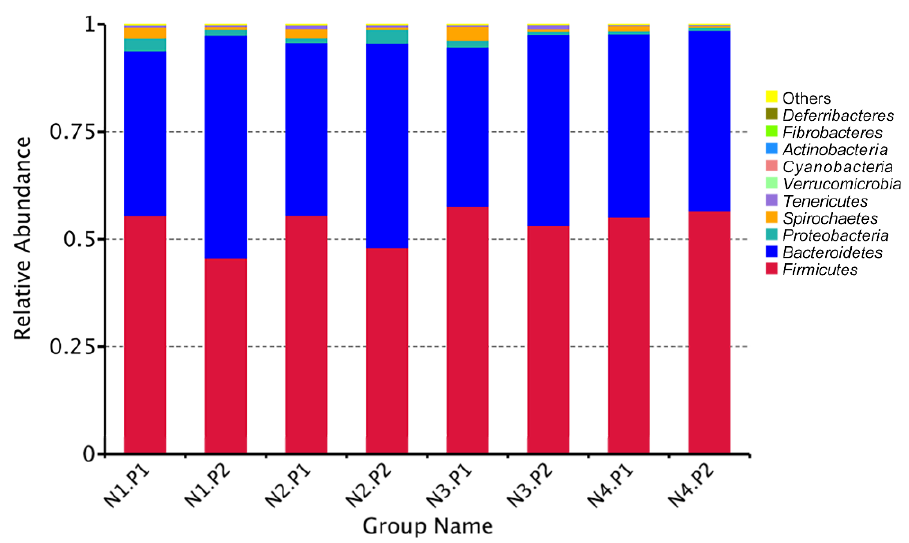
Figure 3. Relative species abundance at phylum level in colonic contents. P1: the experimental period is 7 days. P2: the experimental period is 14 days. N1: 22.5 mg/kg niacin group. N2: 30 mg/kg niacin group. N3: 45 mg/kg niacin group. N4: 75 mg/kg niacin group.